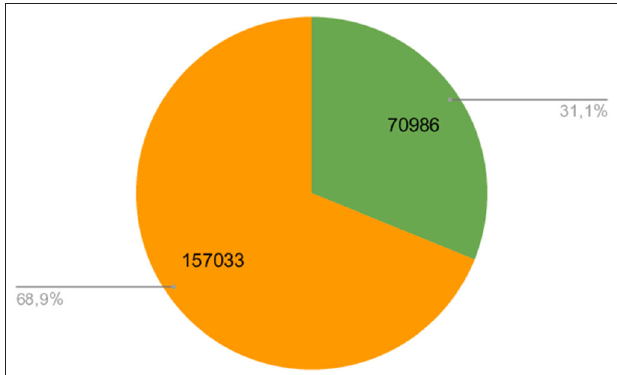
FIGURE 4 | Number of total HMM alignments to graph. The orange section shows the number of HMM hits residing on the scaffolds, and the green section shows the number of HMM hits possibly scattered over multiple scaffolds.